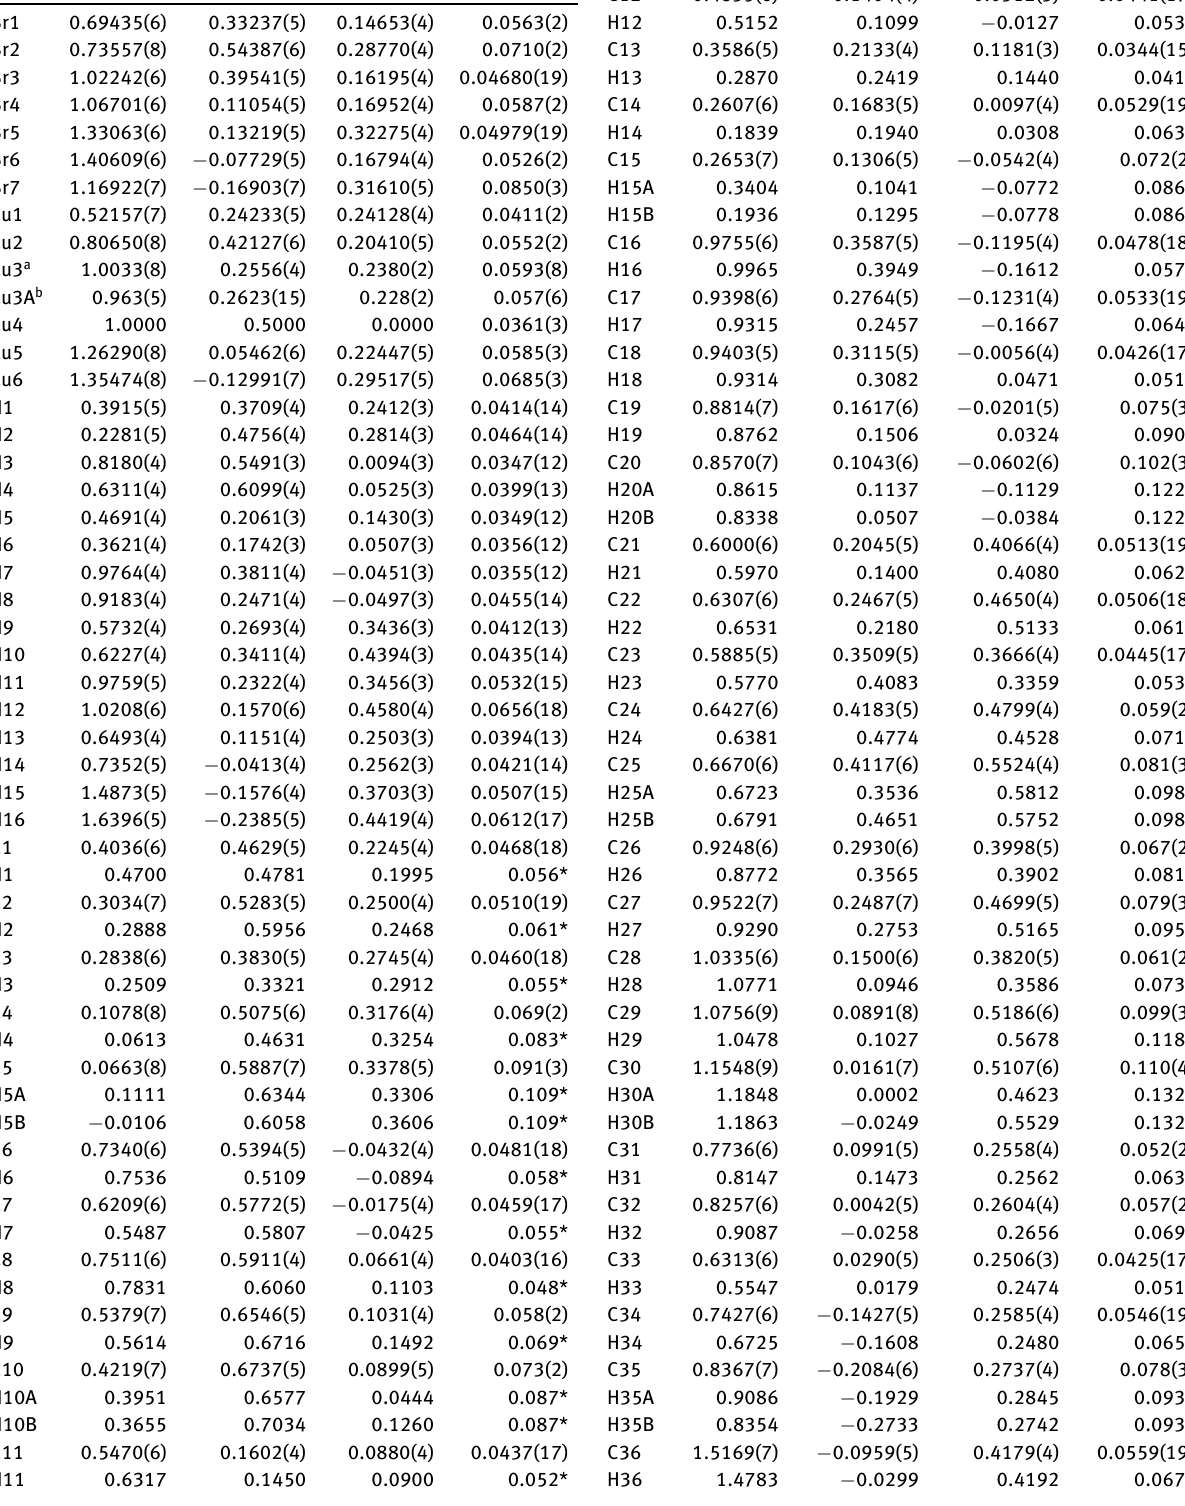
Table 2: Fractional atomic coordinates and isotropic or equivalent isotropic displacement parameters (Å 2